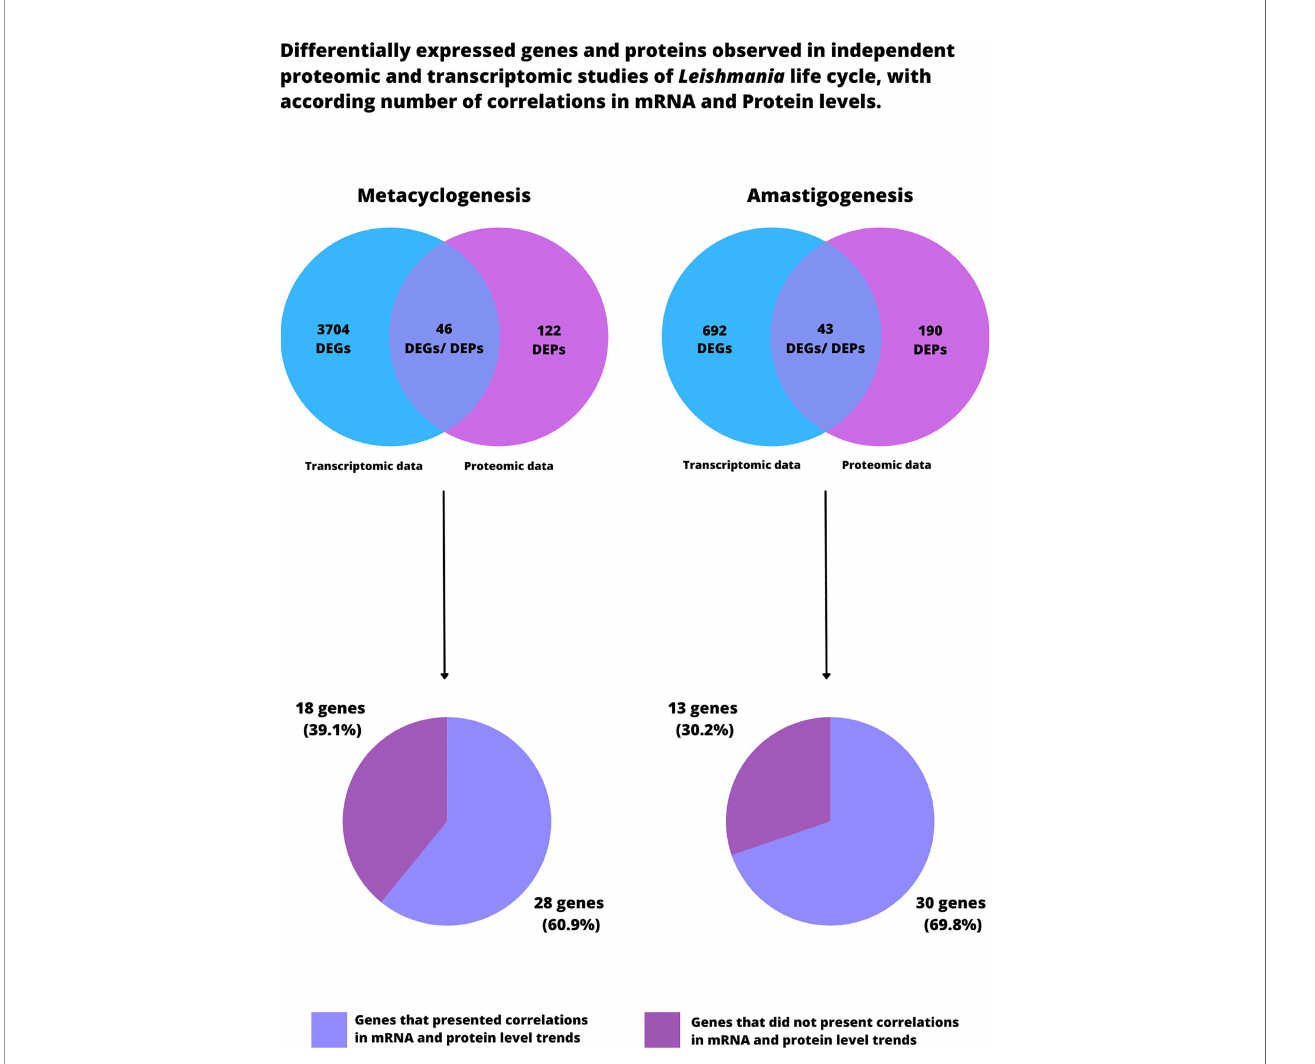
FIGURE 4 | Differentially expressed genes and proteins observed in independent transcriptomic and proteomic studies of Leishmania life cycle. Both Venn Diagrams on the top portion of the fi gure describe the total number of DEPs and DEGs found in all the analyzed studies that was based this review. Further, among the commonly differentially expressed genes, we indicate the amount of genes that presented correlation between mRNA and protein levels in metacyclogenesis and amastigogenesis. It is worth noting that these results should be read as proof-of-concept, since no statistical analysis was performed to compare the analyzed